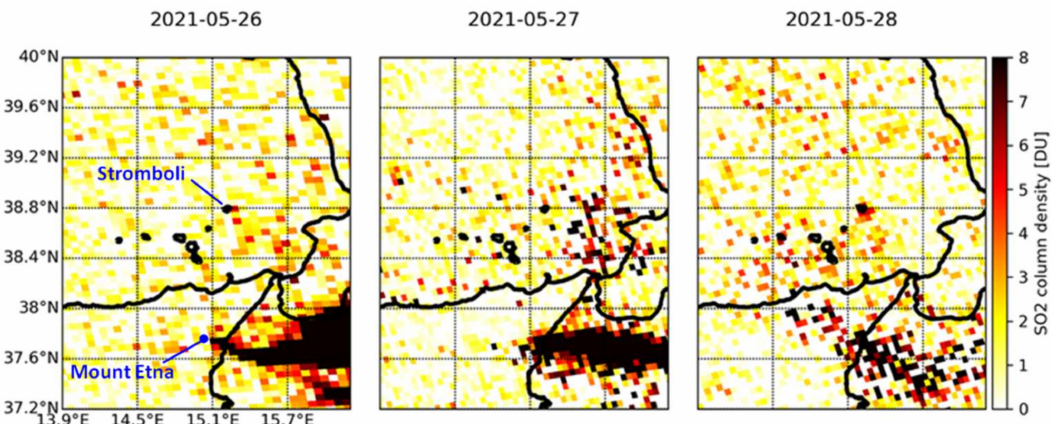
Figure 10. Time lapse of TROPOMI SO 2 column density observations over the Aeolian archipelago and north-eastern Sicily in the period 26–28 May